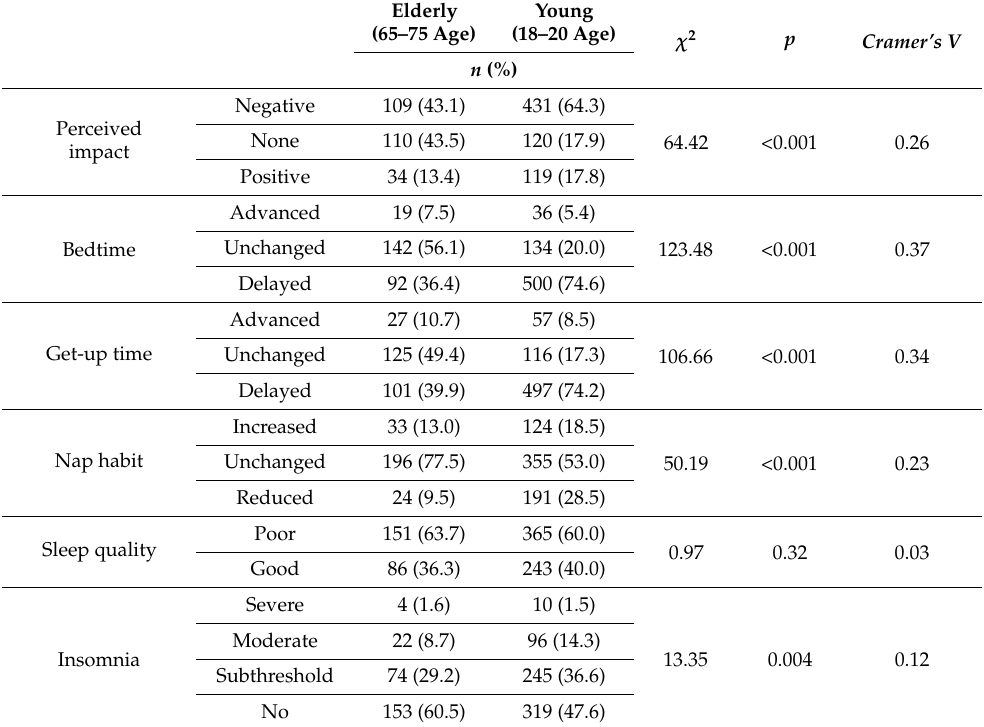
Table 2. Prevalence of the lockdown-related perceived impact on sleep, the reported changes of bedtime, get-up time, and nap habits, and the proportion of poor/good sleepers and clinical insomnia conditions within the two groups (Elderly, Young). Chi-square test results are also reported ( χ 2 , p , Cramer’s V